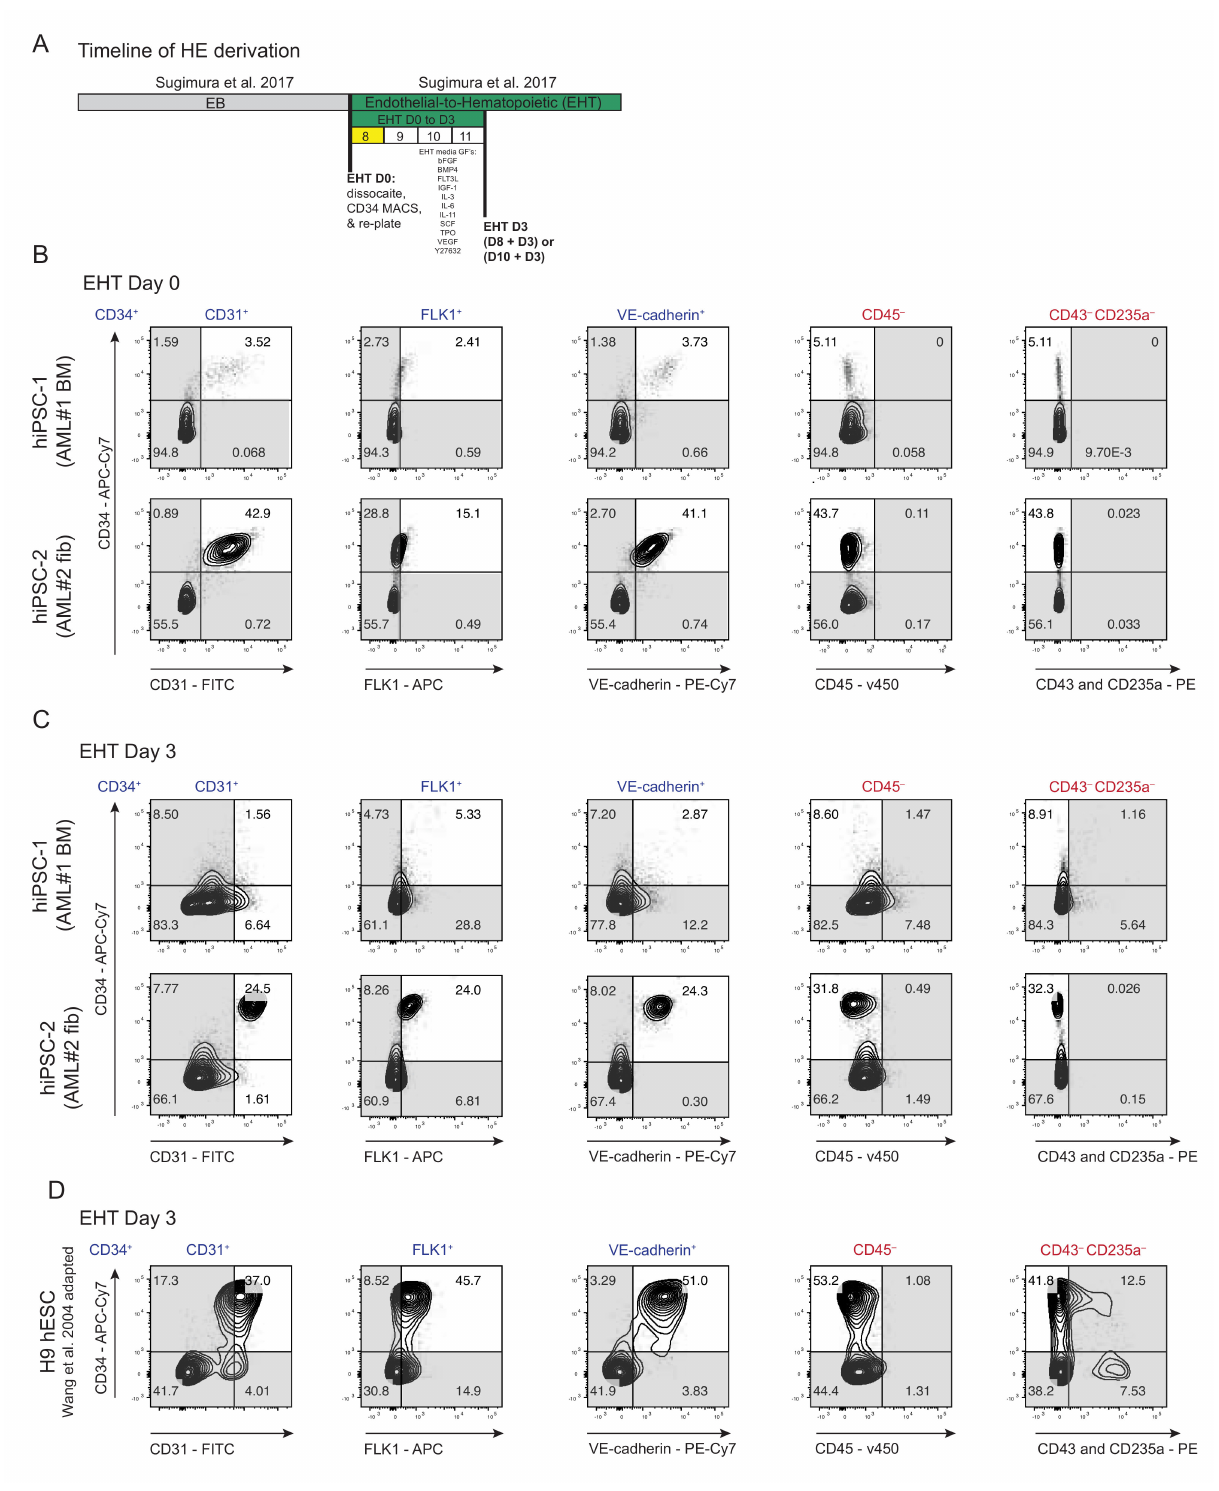
Figure 2. Endothelial-to-hematopoietic transition (EHT) of AML patient-specific iPSCs. ( A ) Schematic depicting simplified timeline of HE derivation used on various hPSCs. HE cells were isolated through dissociation of hEBs and enriched by positive selection of CD34 + through Magnetic-Activated